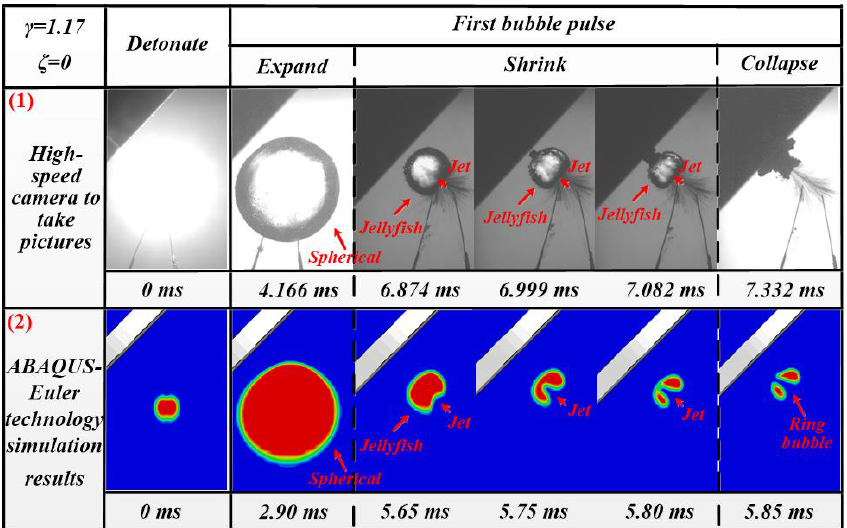
Figure 12. Comparison of experimental results and simulation results. ( 1 ) The pulsation diagram of the first cycle of the bubble taken by a high-speed camera. ( 2 ) The pulsation diagram of the first cycle of the bubble simulated by ABAQUS/Explicit.